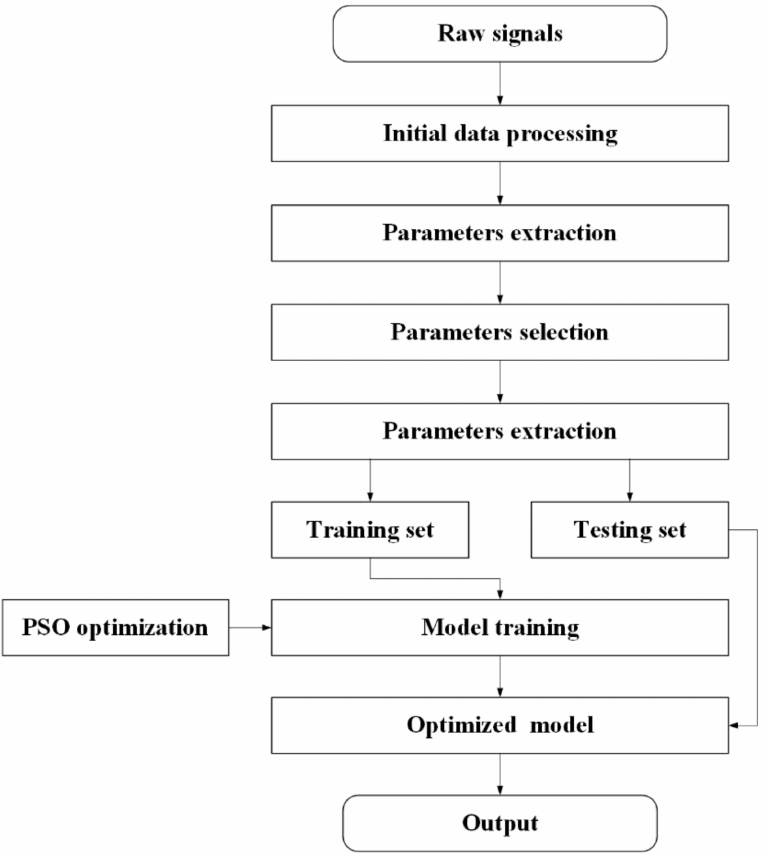
Figure 5. Main steps of the proposed method in